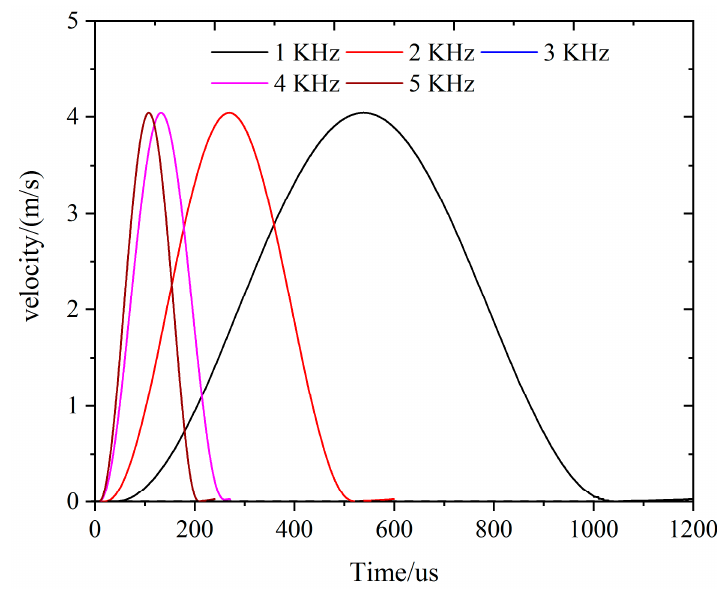
Figure 17. Incident wave with different frequencies.